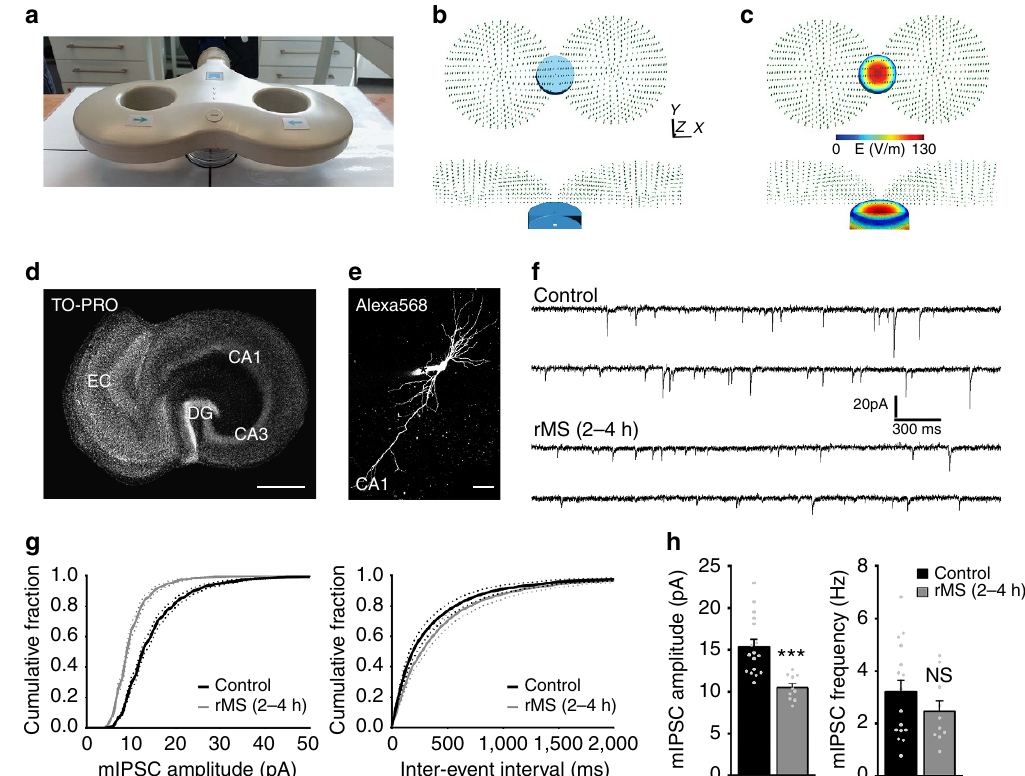
Figure 1 | rMS of mouse entorhinohippocampal slice cultures induces a reduction in inhibitory synaptic transmission. ( a ) A photograph illustrating the experimental setting. Slice cultures (Petri dish below the coil) are stimulated with a standard 70-mm outer wing diameter figure-of-eight coil. Distance from coil, position and orientation of cultures within the magnetic field are kept constant in all experiments 5,6 . ( b , c ) The electric field induced by rMS in vitro was described based on a magnetic dipole model of the 70-mm figure-of-eight coil 62 . A finite element method model was created with the dimensions of the bath (blue) and tissue (grey) adapted to the in vitro setting. The coil was positioned 1cm above the tissue ( b ). The electric field induced in our experimental setting was estimated to be 27.3 ± 3.3Vm (cid:2) 1 in the tissue ( c ), which is within the lower range of clinical TMS motor-evoked potential threshold amplitudes of 30–130Vm (cid:2) 1 (ref. 68). ( d ) Entorhinohippocampal slice culture stained with TO-PRO nuclear stain. All cultures were oriented in the same direction. Four to six cultures were stimulated at the same time (EC, entorhinal cortex; DG, dentate gyrus). Scale bar, 500 m m. ( e ) Patched CA1 pyramidal neuron filled with Alexa568. Asterisk indicates the Alexa568 (10 m M) containing tip of the patch pipette. Scale bar, 50 m m. ( f ) Sample traces of mIPSCs recorded from CA1 pyramidal neurons in non-stimulated control cultures and cultures 2–4h after rMS. ( g , h ) Cumulative distributions of mIPSC amplitudes and interevent intervals ( g ). A significant reduction in the mean mIPSC amplitude but not the mean mIPSC frequency is observed 2–4h after stimulation (h; control, n ¼ 17 neurons; rMS, n ¼ 10 neurons from five cultures each; Mann–Whitney test). Individual data points are indicated by gray dots. Values represent mean ± s.e.m. (*** P o 0.001; ns, not significant